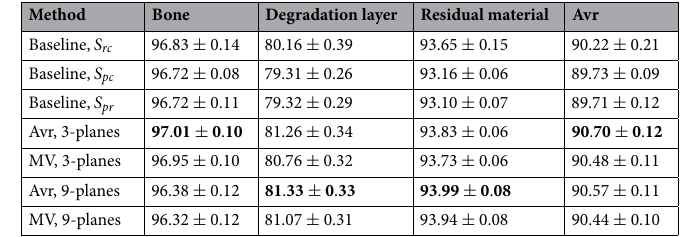
Table 2. Mean Intersection over Union (IoU) and the standard error results for different 3D information fusing methods. Bold text for each column emphasizes the overall highest mean IoU value. All values are scaled by 100 for